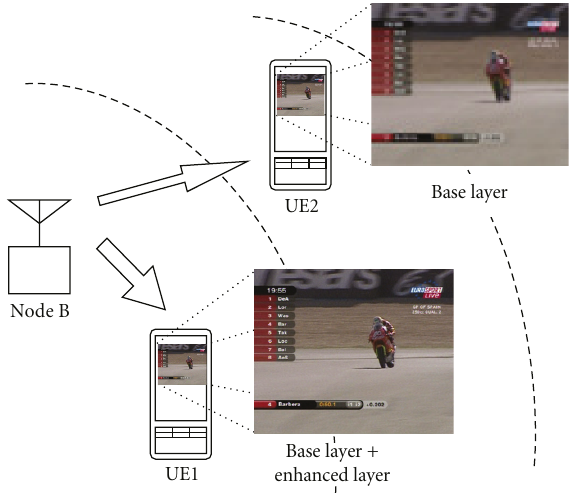
Figure 1: Scalable video transmission.